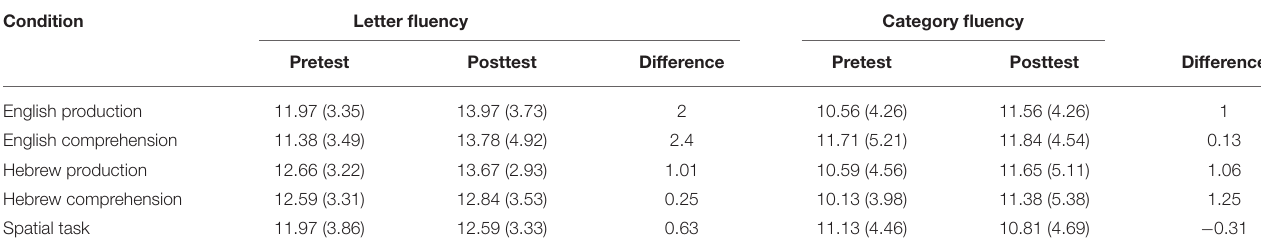
TABLE 2 | Verbal fluency pretest and posttest (untransformed